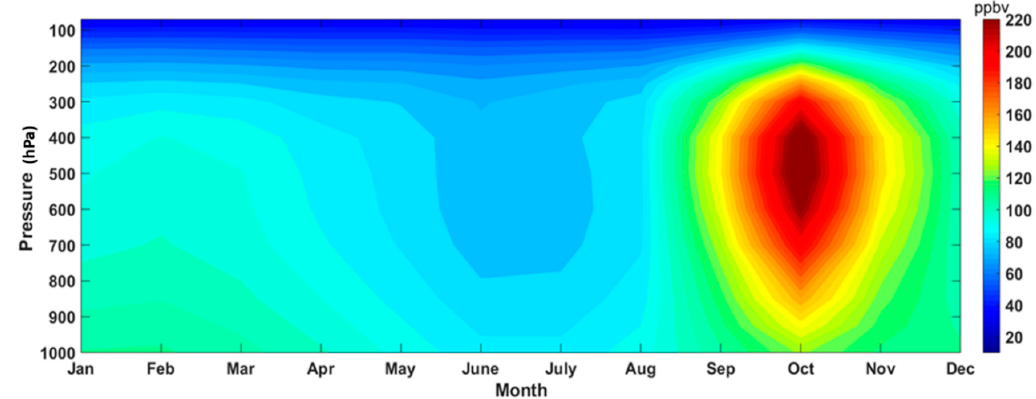
Figure 7. Pressure time cross section of monthly mean carbon monoxide observed over Southeast and Western Pacific region (averaged over 10 ◦ N–10 ◦ S/85 ◦ E–140 ◦ E) from January to December 2015. Asia and Western Pacific region (averaged over 10°N–10°S/85°E–140°E) from January to December To obtain this, AIRS satellite measured carbon monoxide data is 2015. To obtain this, AIRS satellite measured carbon monoxide data is utilized.